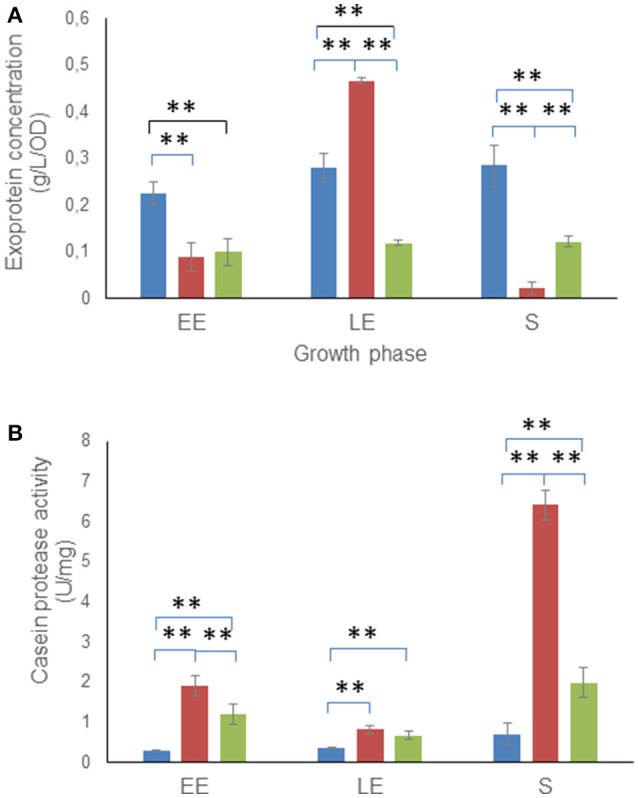
Exoproteome concentration and protease assay. Concentrations (A) and casein proteolytic activity (B) are indicated for total extracellular proteins of WT (blue), ΔmsrAB (red) and ΔmsrAB/pHT304msrAB (green) cells. Error bars represent the standard deviation from two independent measures for each biological triplicate. Significant differences (p < 0.01) between WT, ΔmsrAB and ΔmsrAB/pHT304msrAB strains are indicated with two asterisks.